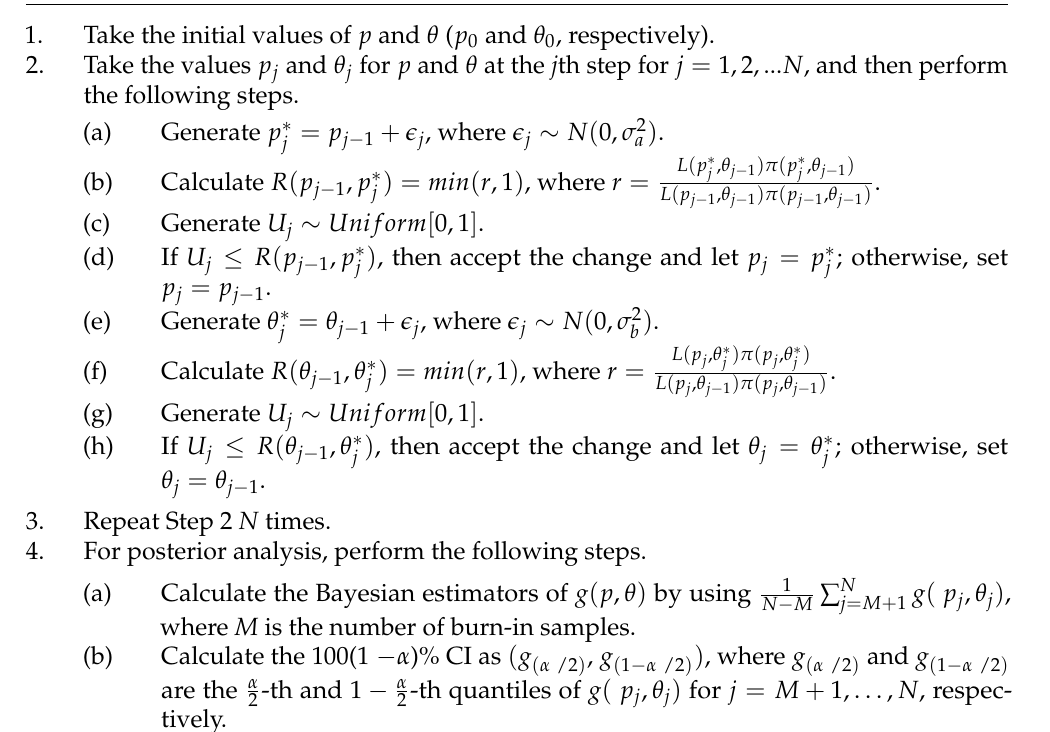
Algorithm 2 Establishing the Bayesian CIs for parameters p and θ .